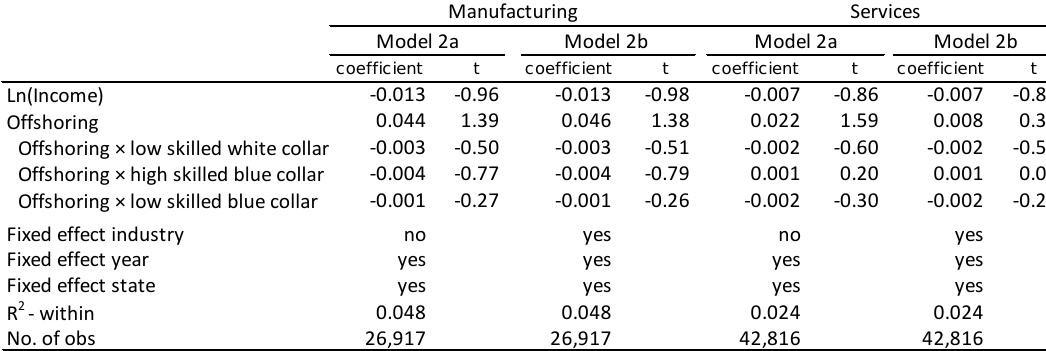
Table 6. Job insecurity and offshoring, by